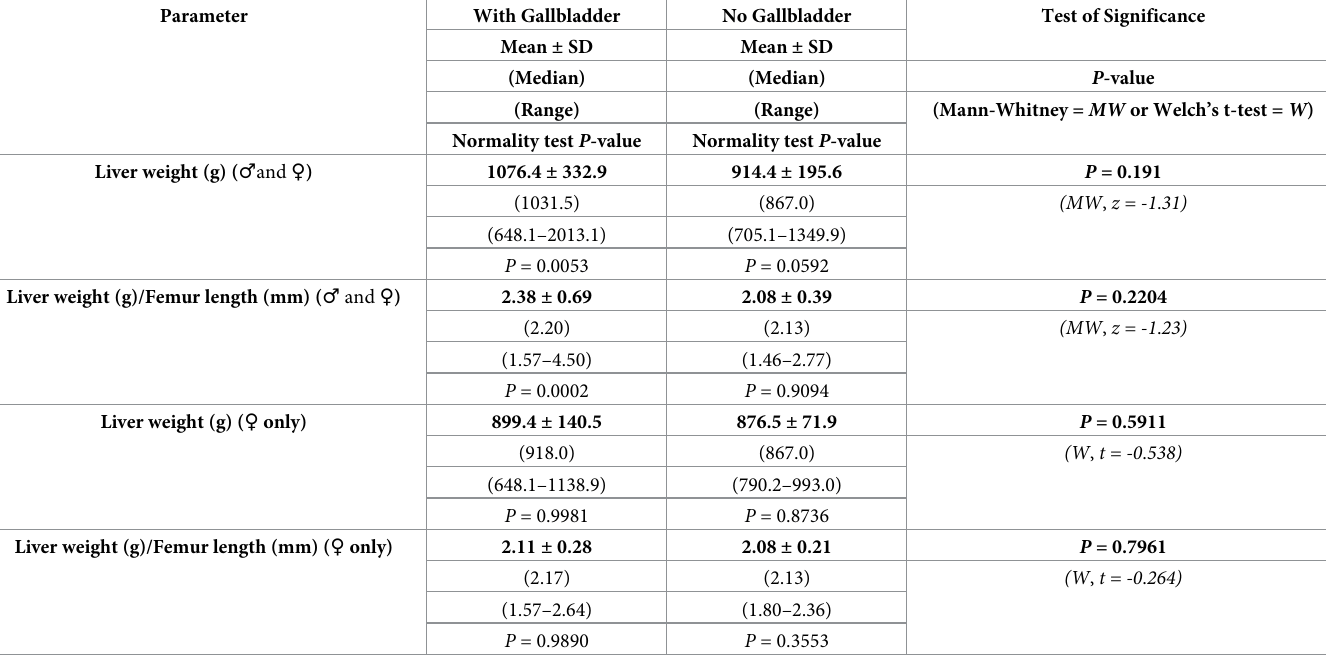
Table 2. Comparison of liver weights (raw and corrected for femur length) in cadavers with and without gallbladders. Parameter